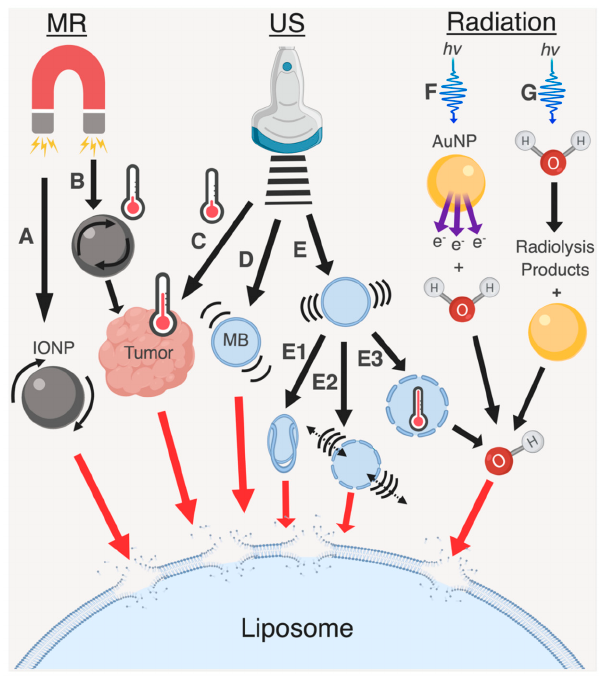
Figure 5. Schematic of the mechanisms associated with MR, US, and RT that can be used to destabilize liposomes. The mechanisms are as follows: ( A ) MR induced mechanical disruption; ( B ) MR induced hyperthermia; ( C ) US induced hyperthermia; ( D ) US induced stable cavitation of a MB; ( E ) US induced inertial cavitation of a MB; ( E1 ) The production of a liquid microjets from a MB undergoing inertial cavitation; ( E2 ) The production of shockwaves from a MB undergoing inertial cavitation ; ( E3 ) A MB collapsing and undergoing sonochemical changes; ( F , G ) The interaction of radiation with AuNPs and water to produce hydroxyl radicals that destabilize liposome bilayers.